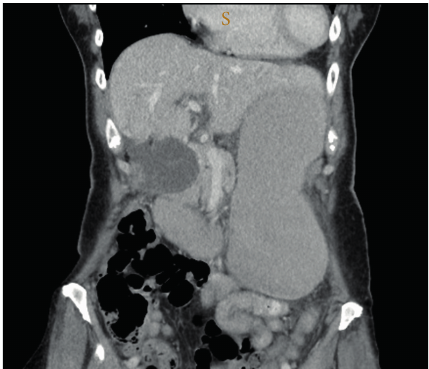
Figure 1: Reconstructed coronal images on computed tomography demonstrating the dilated and relatively inferiorly placed gallblad- der. Acute gastric distension was also present due to duodenal com- pression by the very dilated gallbladder (not shown).